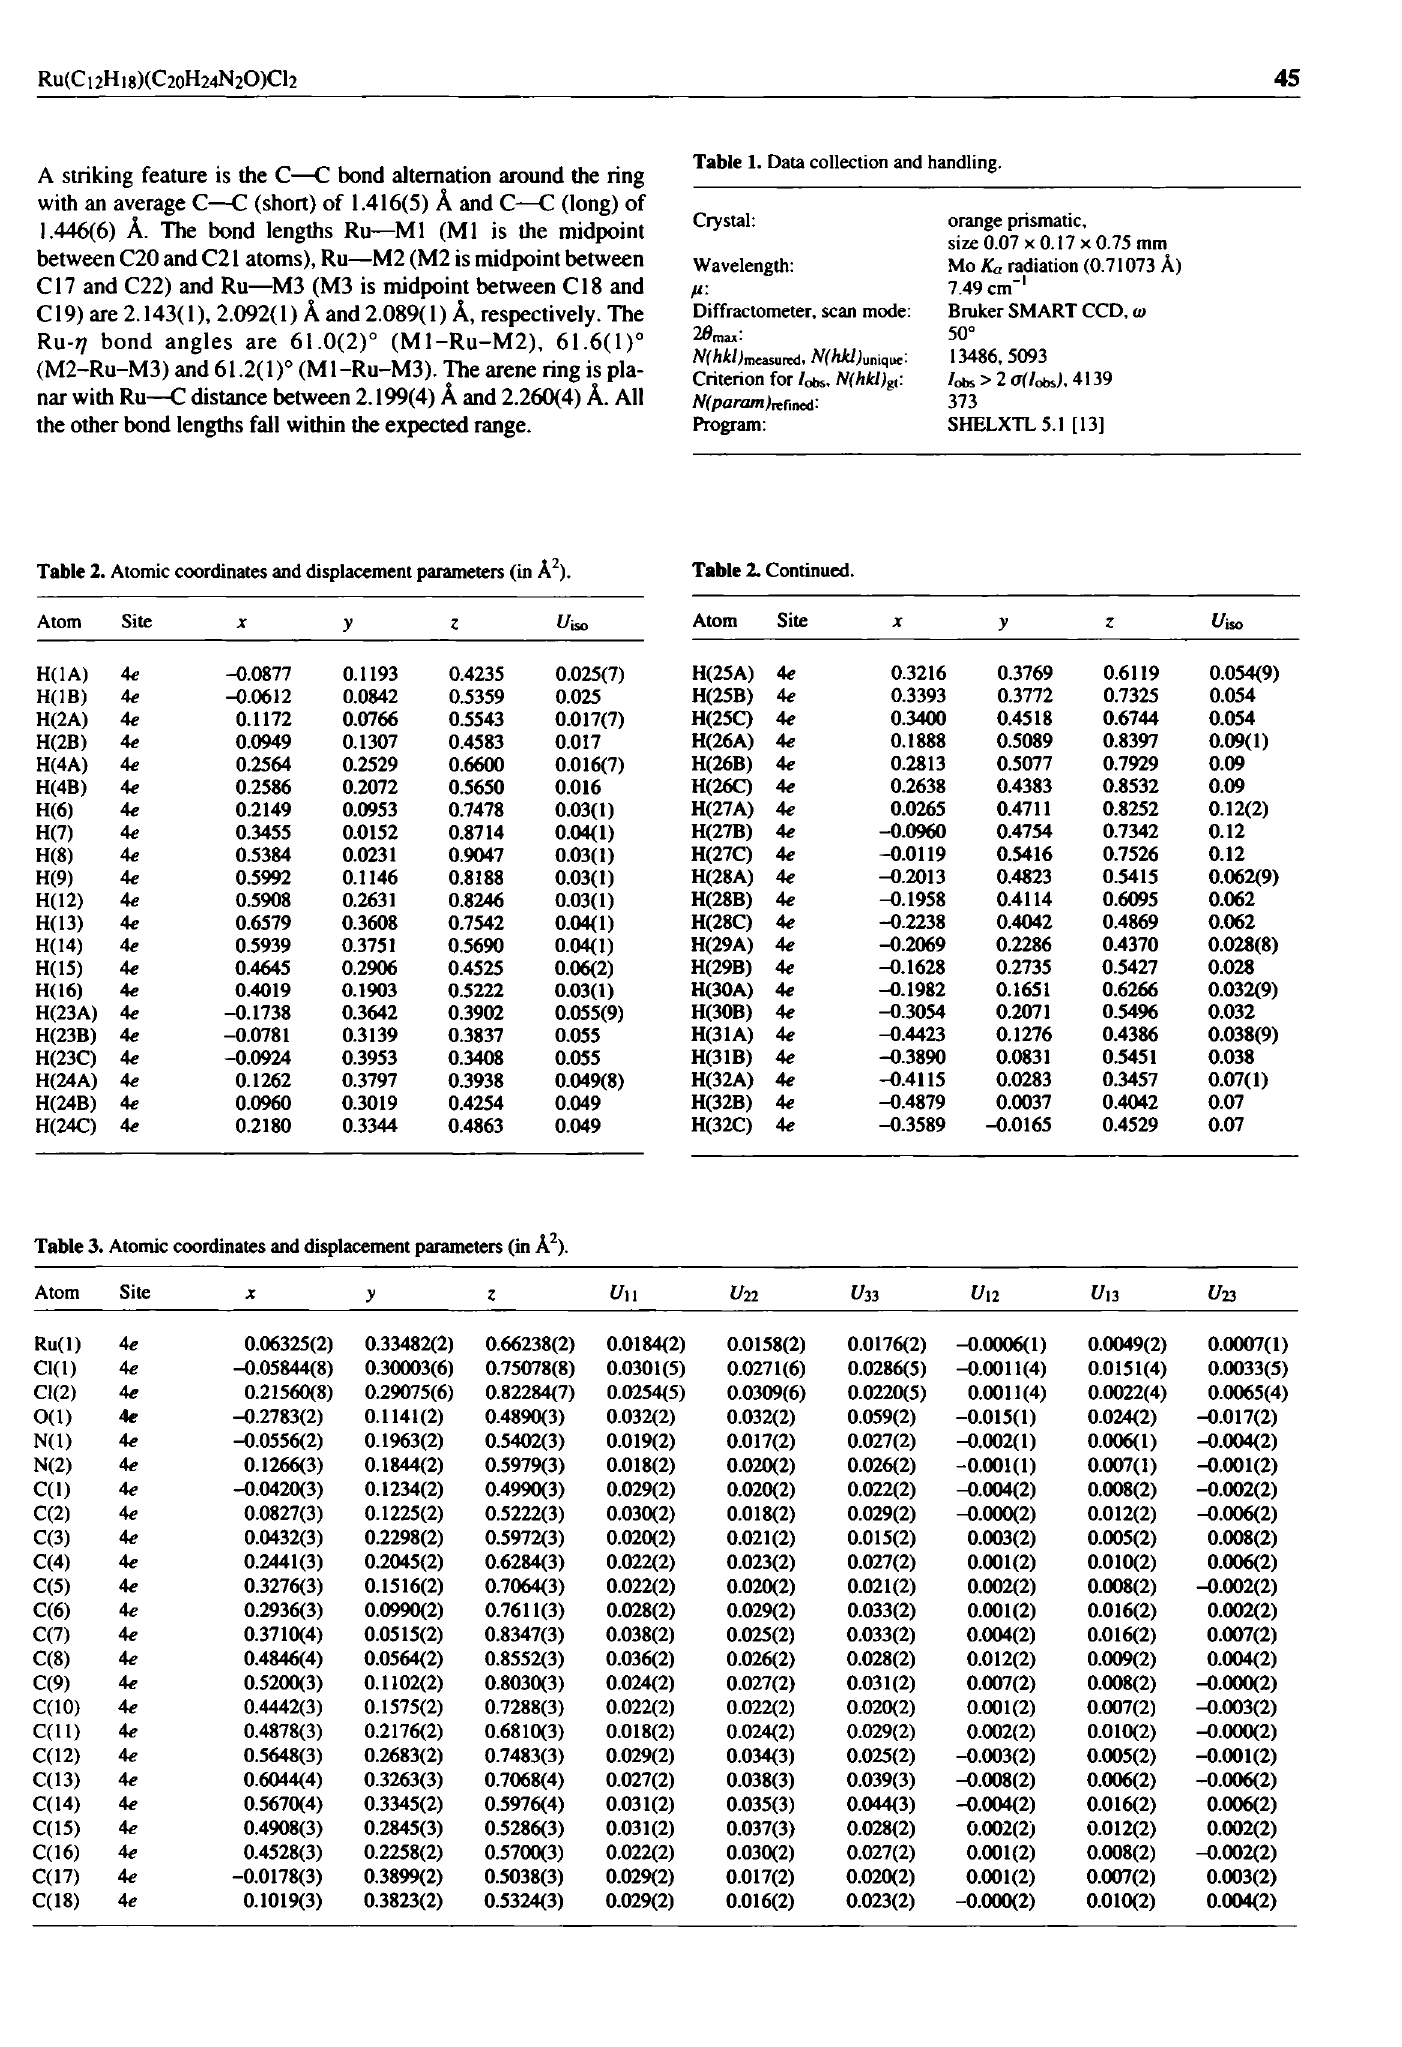
Table 3. Atomic coordinates and displacement parameters (in A 2